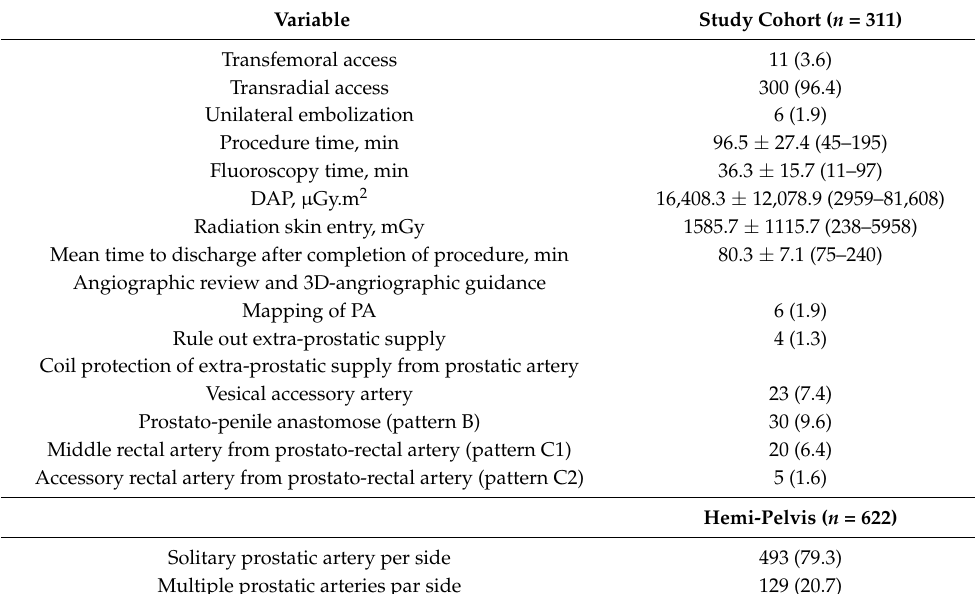
Table 2. Procedure characteristics of the study cohort.